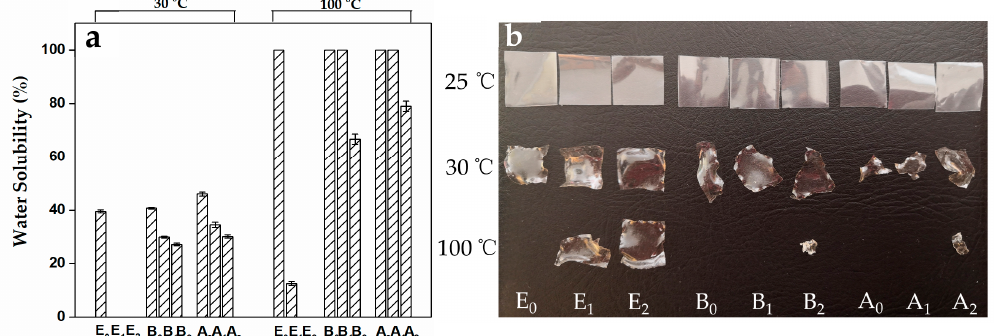
Figure 5. Water solubility (at 30 °C and 100 °C) of unmodified and MTGase modified gelatin films ( a ) and their photographs before and after water solubility test ( b ).